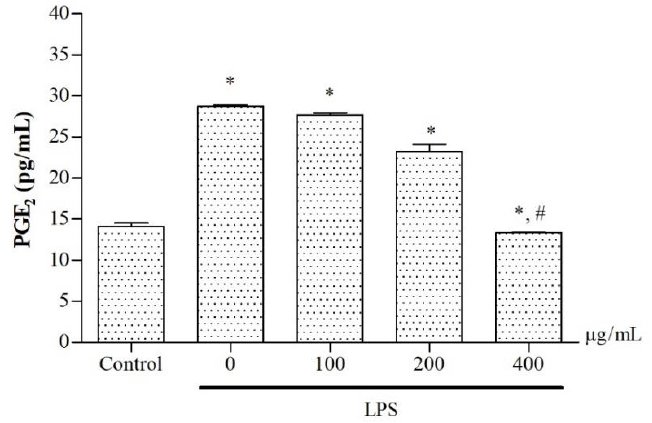
Figure 6. Levels of PGE 2 production in LPS-induced RAW264.7 macrophages after being treated with 50% ethanolic extract of P. odoratum Lour. cv. Pakphai leaves at various concentrations for 24 h. Data obtained from three independent experiments are expressed as mean ± SEM values. Accordingly, * p < 0.05 was considered significant when compared to control cells without LPS induction; # p < 0.05 was considered significant when compared to LPS-induced cells without the extraction treatment. Abbreviations: COX-2 = cyclooxygenase 2, LPS: lipopolysaccharide, SEM = standard er- ror of the mean values.